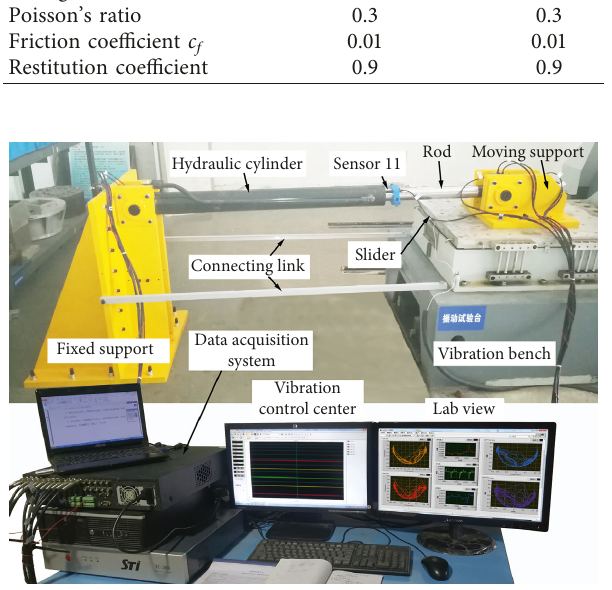
Figure 12: Photograph of test rig.